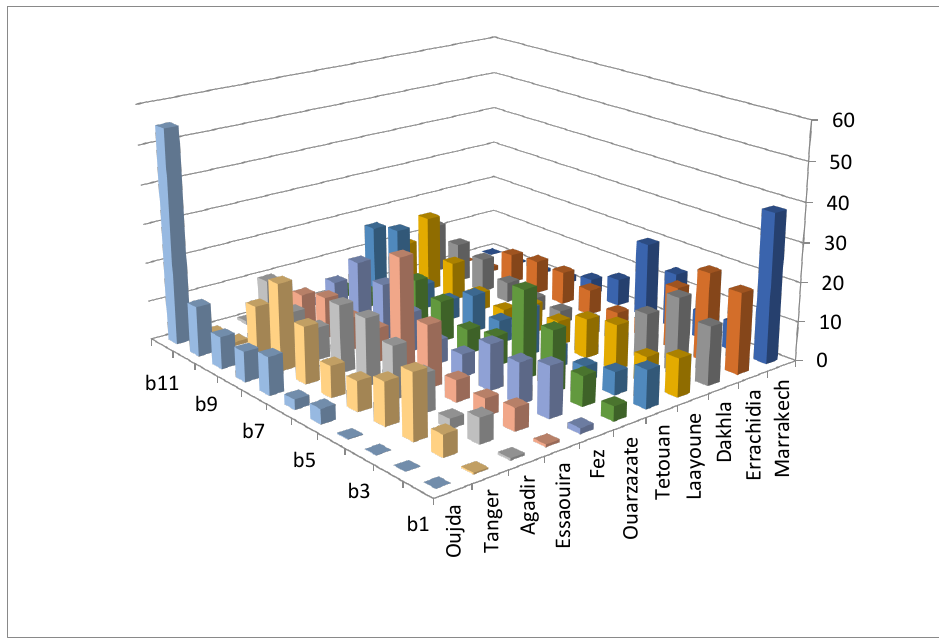
Figure 2. Rank acceptability indices b r for alternatives based on 4 i